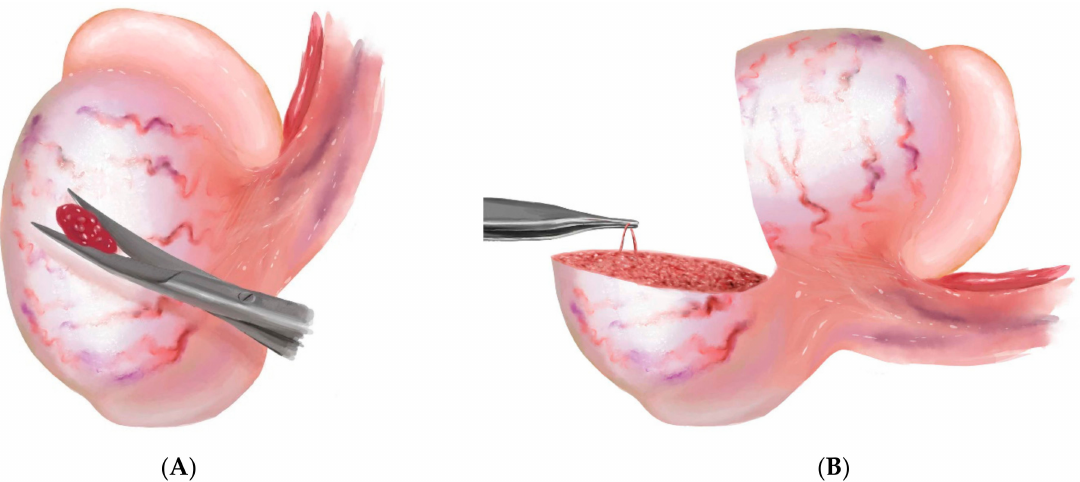
Figure 2. Graphical representation of a ( A ) conventional testicular sperm extraction with or without an operating microscope and ( B ) microdissection testicular sperm extraction using an operating